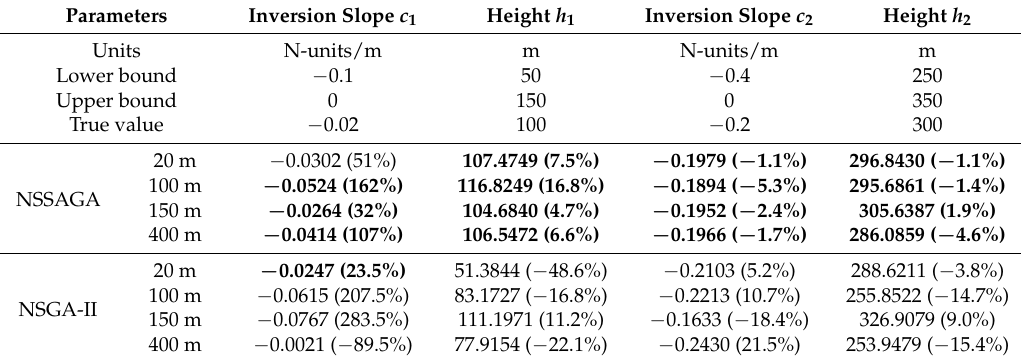
Table 1. The value of inversion parameters under noiseless and added noise conditions (bold font indicates best retrieved parameters).